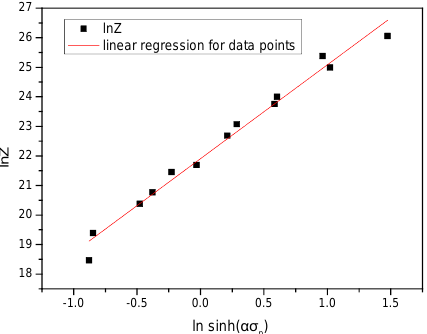
(cid:0) (cid:1) ασ p .